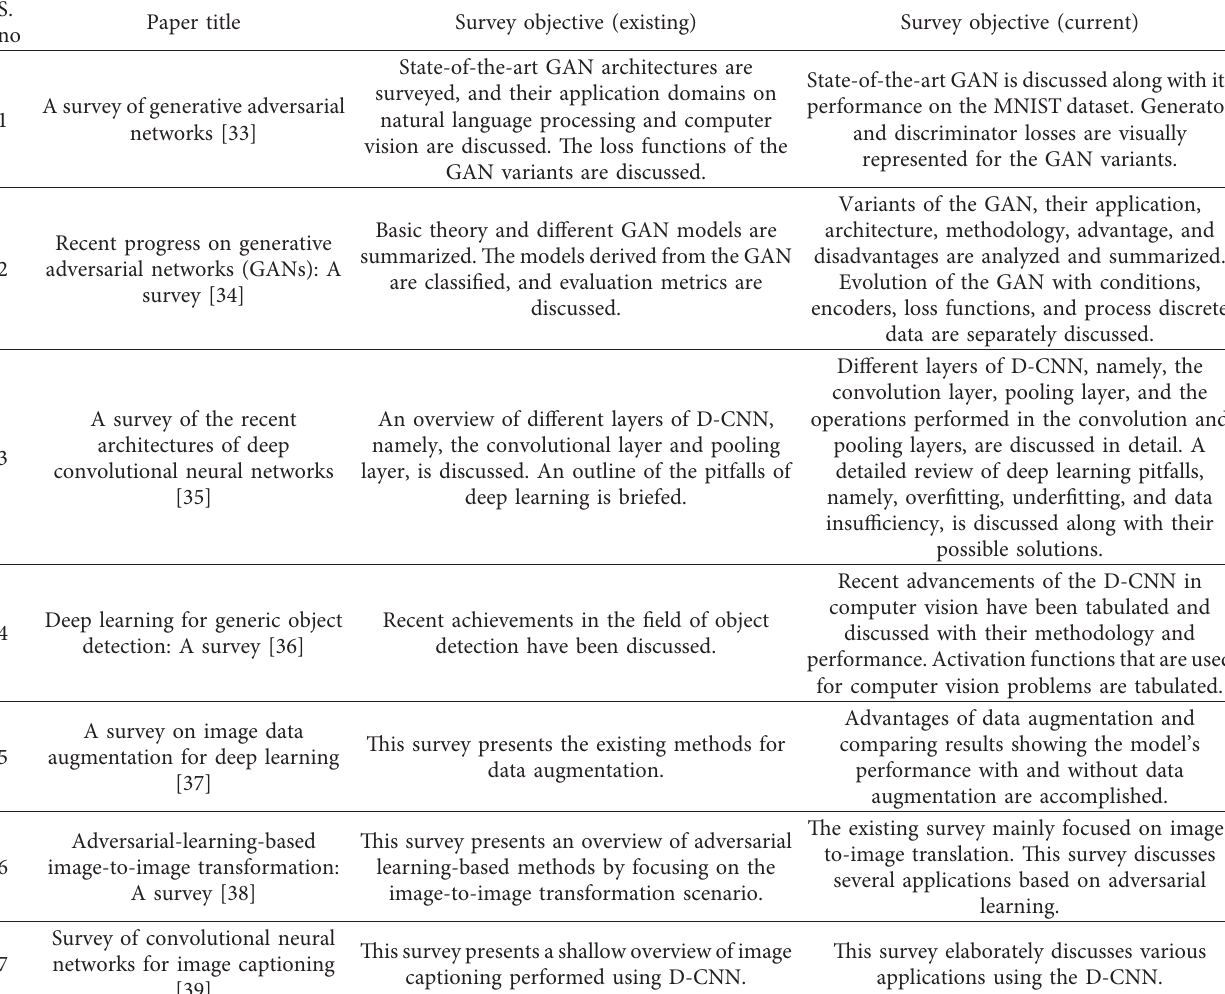
Table 2: Comparison between the current and the existing surveys in the